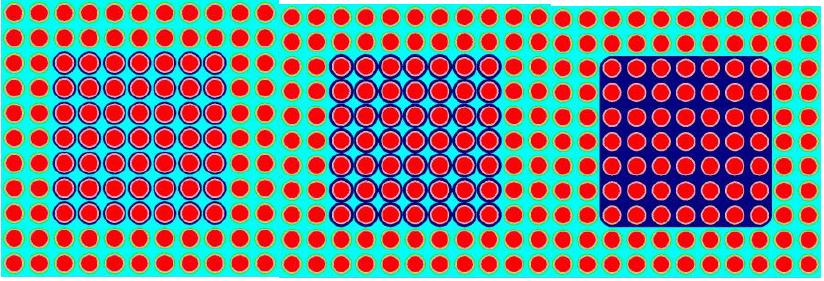
Figure 2. : UH1.2 30 %, 50% and 100% void configurations – Central